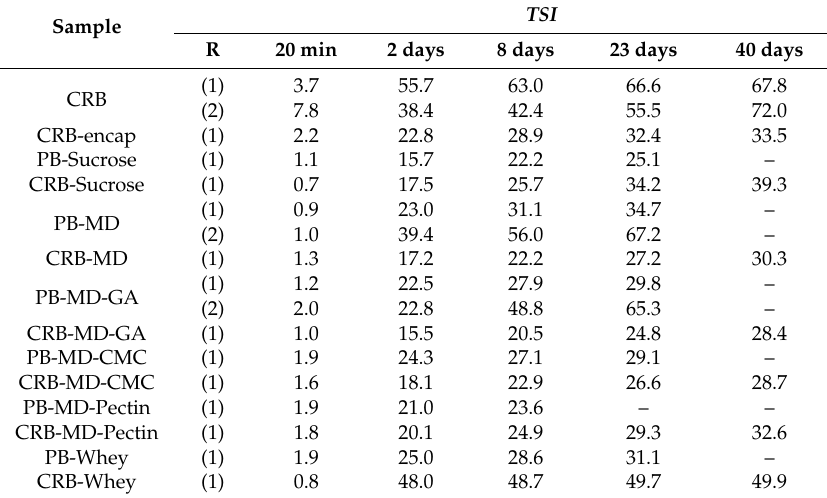
Table 4. Stability Indexes of microcapsule water dispersions at different periods of time. (–: not measured, (1) & (2): Replicates 1 and 2). Replicates (1) and (2) had a concentration of 0.3 mg/mL and 1.5 mg/mL of microcapsule powder respectively.